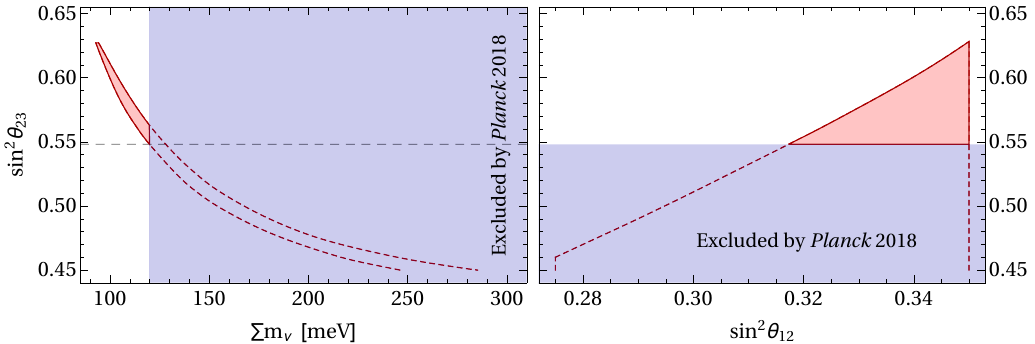
Figure 2 . The correlation among sin 2 (cid:18) 23 , sin 2 (cid:18) 12 , and P m (cid:23) in model 4. The pink-shaded areas in this (cid:12)gure are equivalent to the pink-shaded area in the bottom-left panel of (cid:12)gure 1. A dashed line marks the minimum value 0.548 of sin 2 (cid:18) 23